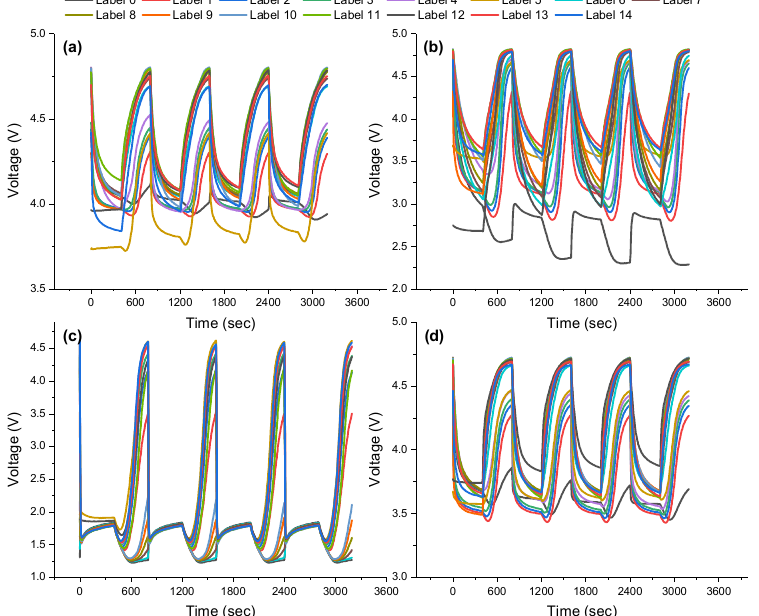
Figure 2. Gas sensing responses obtained from four SMO gas sensors (( a ) S0 for the NO x sensor; ( b ) S1 for the VOC sensor; ( c ) S2 for the CO sensor; ( d ) S3 for the alcohol sensor), according to artificially designed gas mixture combinations tuned to deep learning-assisted gas detection/classification are described in Table 1. (Note that the total number of gas mixtures is 15).